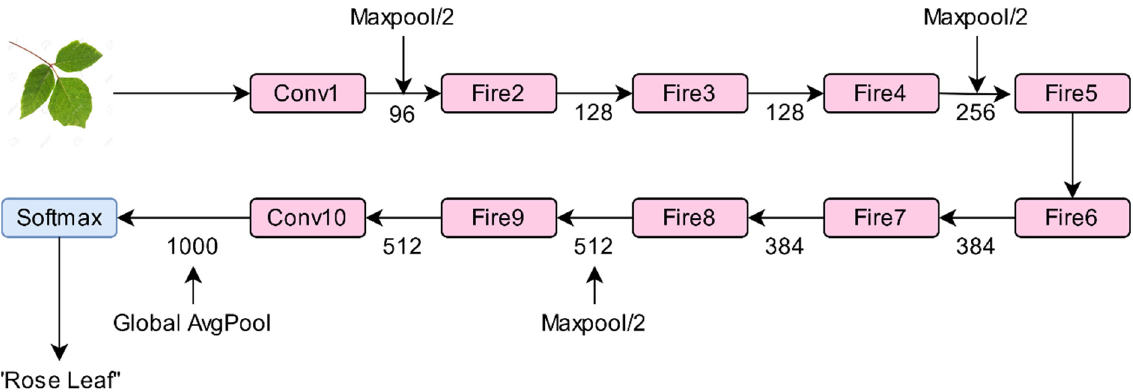
Figure 10. Architecture of SqueezeNet [83].